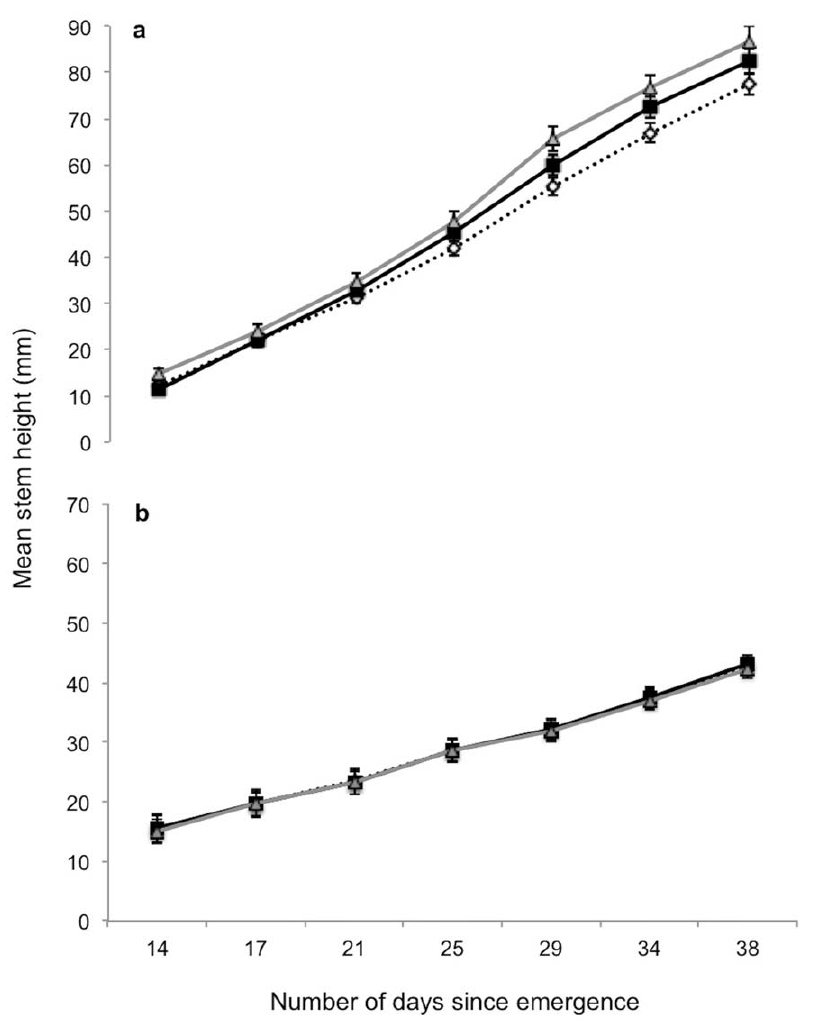
Figure 4. Early growth of chilli seedlings depends on the presence and identity of their neighbour. ( a ) Seedlings growing next to a fennel (grey solid line and triangles) are marginally significantly taller than those growing next to an adult chilli plant (black solid line and squares; Pair-wise contrasts, P=0.07) and significantly taller than seedlings in the empty control (black dotted line and white diamonds; Pair-wise contrasts, P=0.01). The observed differences in above-ground growth among treatments (adult fennel plant, grey solid line and triangles; adult chilli plant, black solid line and squares; empty control, black dotted line and white diamonds) are amplified over time. Only plants that emerged by day 14 are included in these analyses (n=32 per treatment). Error bars indicate standard errors. ( b ) Growth differences disappear when seedlings are allowed to grow in the absence of any adult plant after emergence (n=80 per treatment). Error bars indicate standard errors.